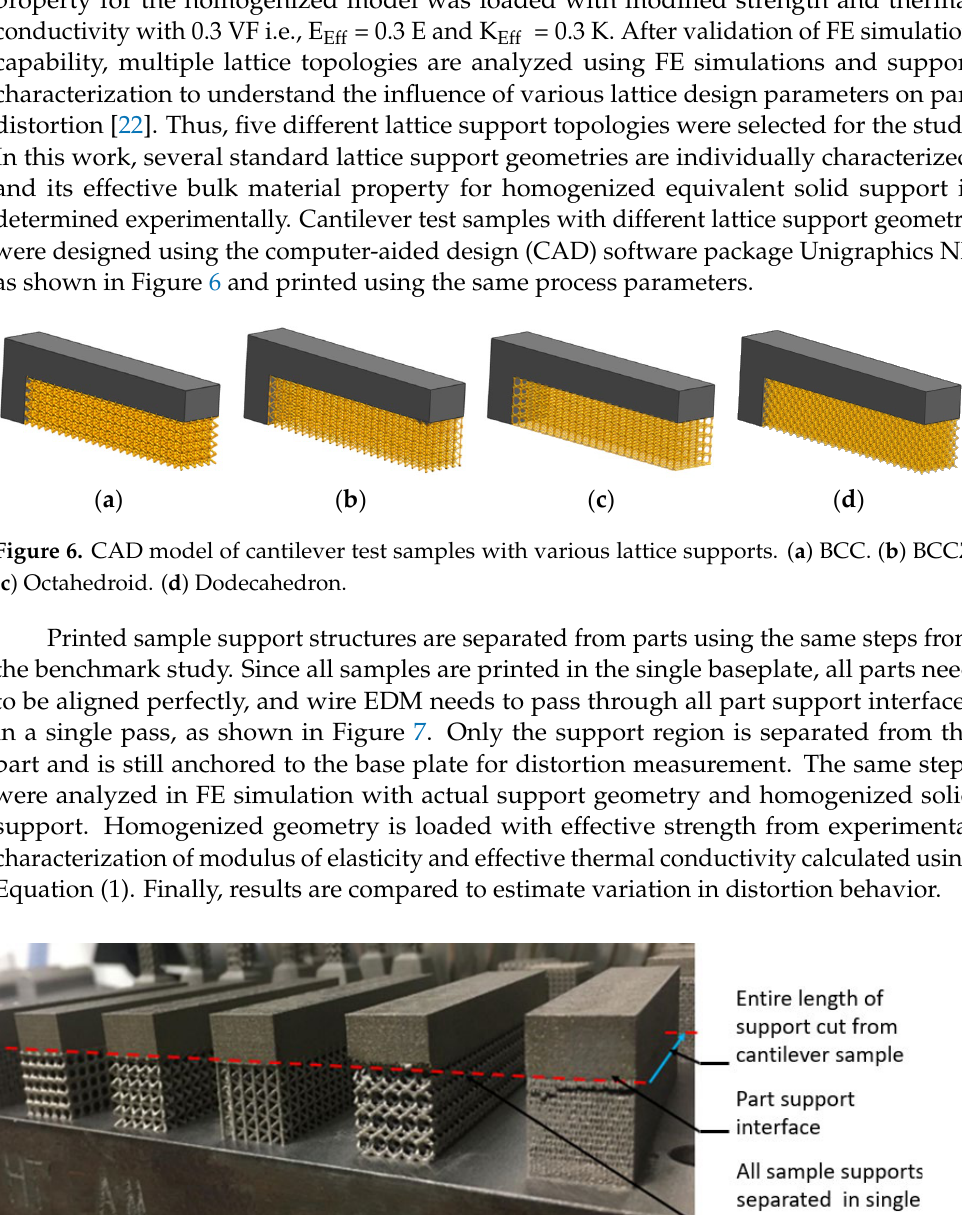
Figure 5. FEA details to simulate experimental steps of support removal. ( a ) Boundary condition in FE model. ( b ) FE simulation result after support removal.